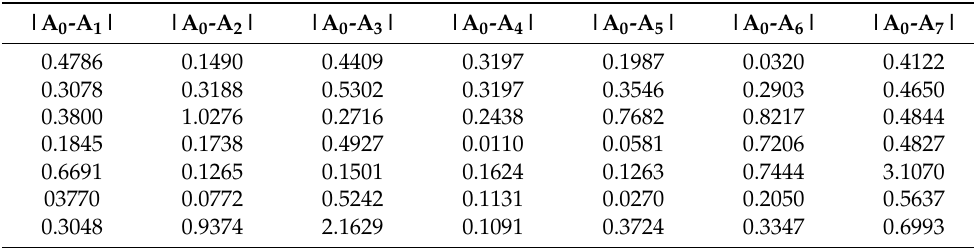
Table 4. Absolute value difference data of surface subsidence influencing factors in Lu’an mining area.